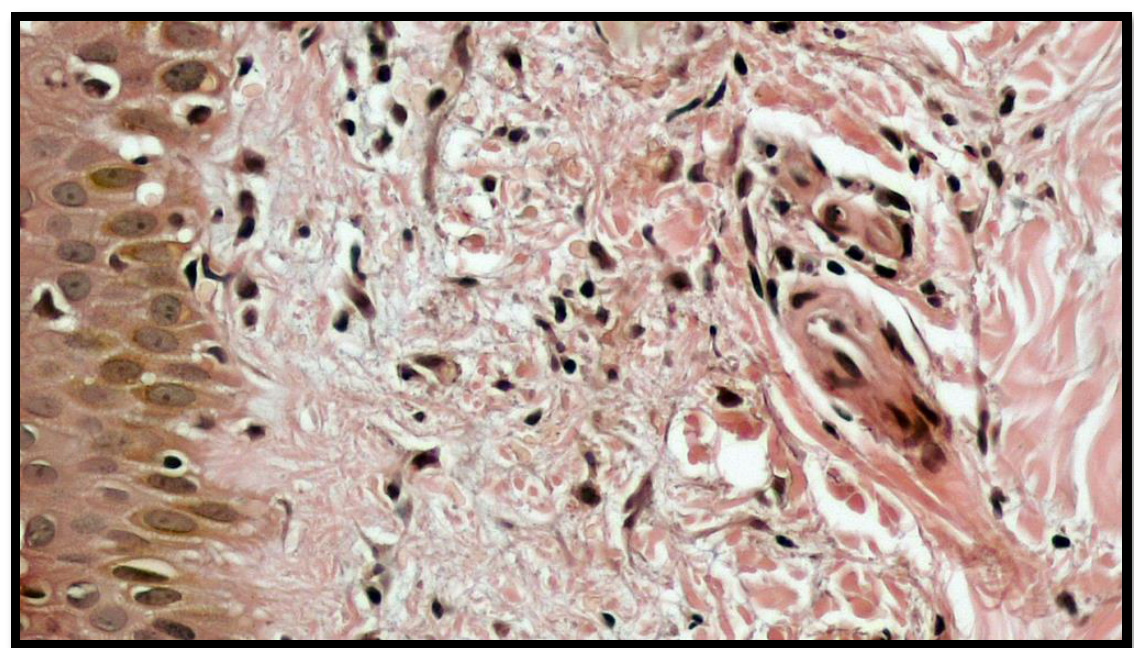
Figure 5. Detail at greater magnification that shows the presence of erythrocytes between the colla-